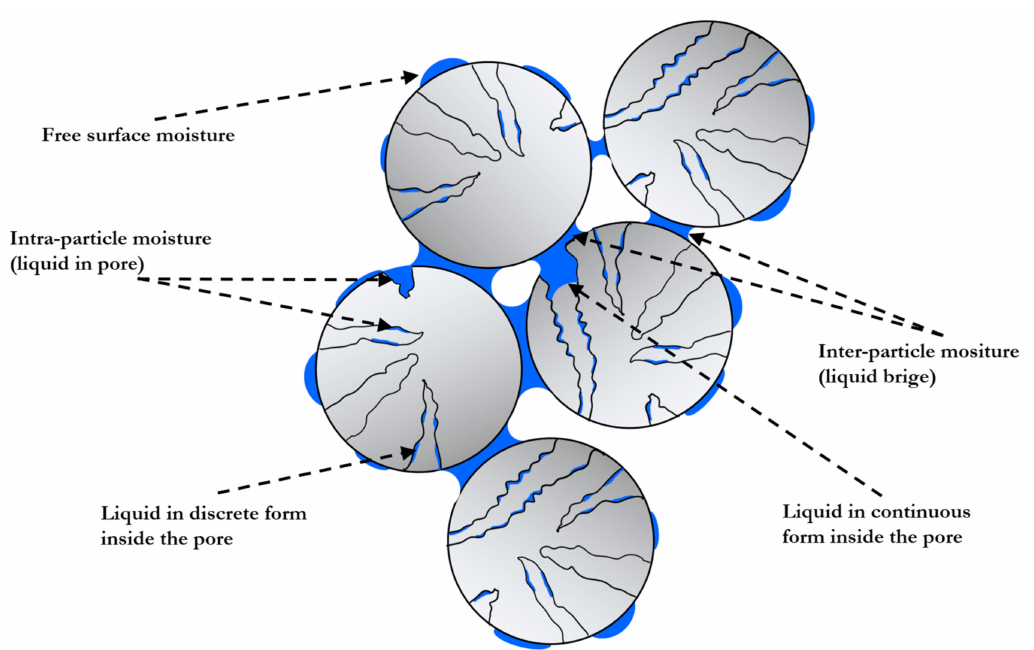
Figure 5. Different types of liquid in a